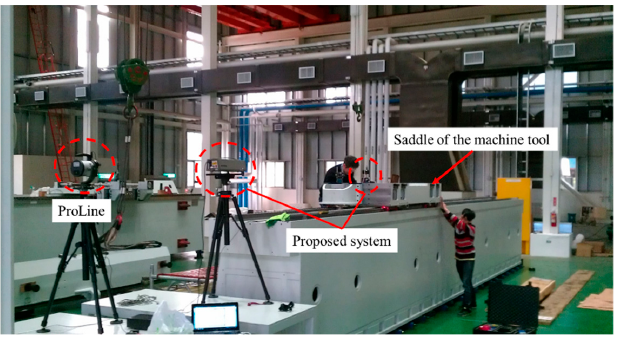
Table 6. Case 1 straightness error measurement results.